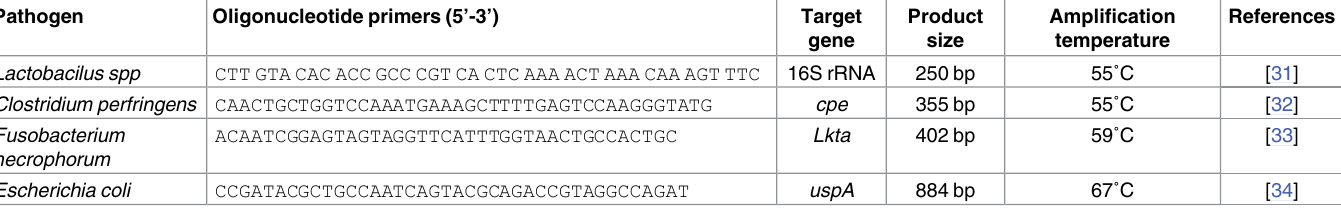
Table 2. Specifications of the PCR assaysapplied to the detection of microbial DNA from ileum and cecum samples.